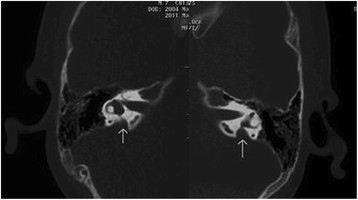
Image of the bilateral enlarged vestibular aqueducts.